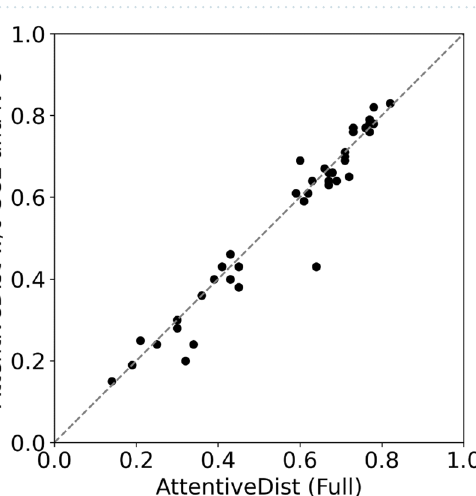
Figure 7. Performance in structure modelling. ( a ) TM-score for AttentiveDist, AttentiveDist without using predicted sidechain center distance and backbone N–O distance and the top 3 server methods in CASP13 for 43 FM and FM/TBM targets. ( b ) Individual target TM-score comparison between our method and the Zhang-Server. The registered name of Raptor-X in CASP13 was RaptorX-DeepModeller and BAKER- ROSETTASERVER for Rosetta Server.